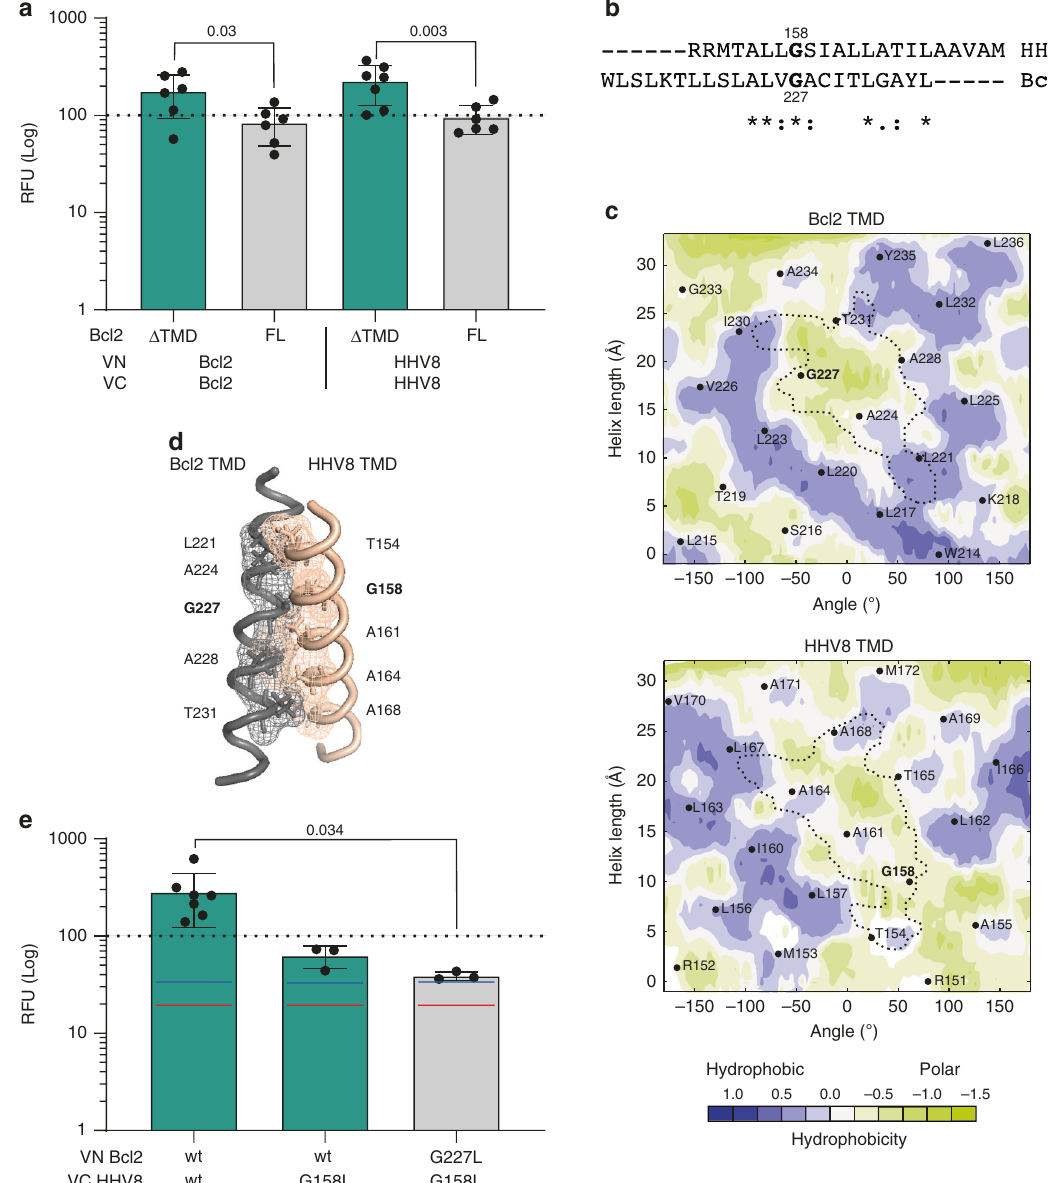
Fig. 4 Interaction between HHV8 and Bcl2 TMDs. a The BiFC-derived fl uorescence (RFU) for the homo-oligomerization of Bcl2 (left) or HHV8 (right) TMDs was measured in the presence of Bcl2 (FL) or Bcl2 Δ TMD ( Δ TMD) in HEK 293T cells. The mean and standard deviation of at least six independent experiments are shown ( n ≥ 6). Solid dots represent the results of individual experiments. The GpA TMD homodimer was used as a positive control and as the normalization value (dotted line). A signi fi cant (two-tailed homoscedastic t -test) decrease in the fl uorescence is highlighted in gray, p -values are indicated. b Sequence alignment of Bcl2 and HHV8 TMDs. The alignment was done with Clustal Omega (EMBL-EBI). c Predicted (PredDIMER) contact area between Bcl2 and HHV8 TMDs. The position (length and angle) of each residue in a putative α -helix are indicated. A dotted line encircles the contact area in each TMD. The hydrophobicity of the residues is shown with a color scale. As expected, there are many hydrophobic residues in both TMDs. However, the contact area between both α -helices is mostly hydrophilic. d Model of a putative dimer between Bcl2 TMD and HHV8 TMD, obtained with PredDIMER. The residues involved in the interaction are indicated, conserved glycine residues in Bcl2 and HHV8 are highlighted in bold. e Bcl2 and HHV8 TMD hetero-oligomerization measured by BiFC in HEK 293T cells. Fluorescence from the VN GpA/VC-GpA homodimer was used to normalize the signal (dotted line). The mean and standard deviation of at least three independent experiments are shown ( n ≥ 3). Solid dots represent the results of individual experiments. The blue (VN T20 TMD) and red (VC T20 TMD) lines indicate the fl uorescence of the controls used for the statistical analysis (two-tailed homoscedastic t -test), green bars denote RFU values above the controls, p -values are An in silico analysis of the potential dimer interface (done with Preddimer, a TM segment dimer prediction software program 41 ) suggested that conserved glycine residues between Bcl2 and HHV8 TMDs (at positions 158 and 227, respectively) could be located at the contact surface of a putative HHV8-Bcl2